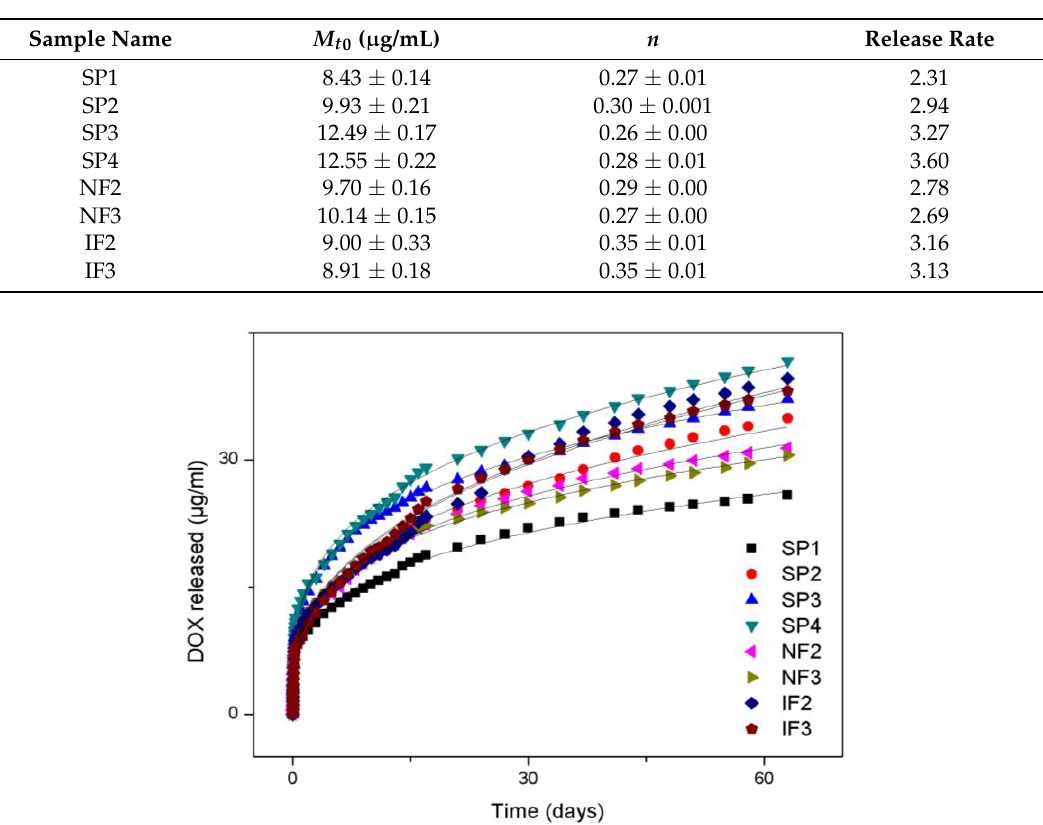
Table 2. Korsmeyer–Peppas equation fitting parameters.